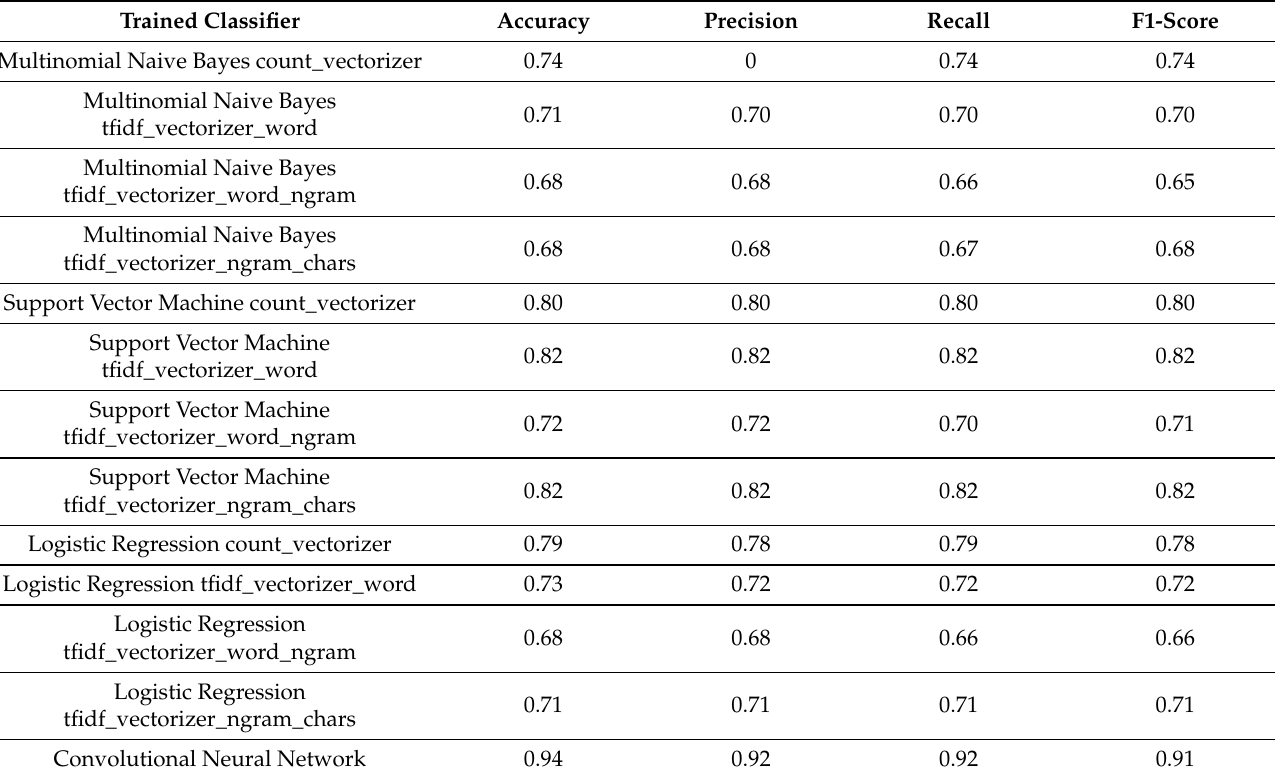
Table 6. Comparison of the performance achieved from each classifier with oversampling. Trained Classifier Accuracy